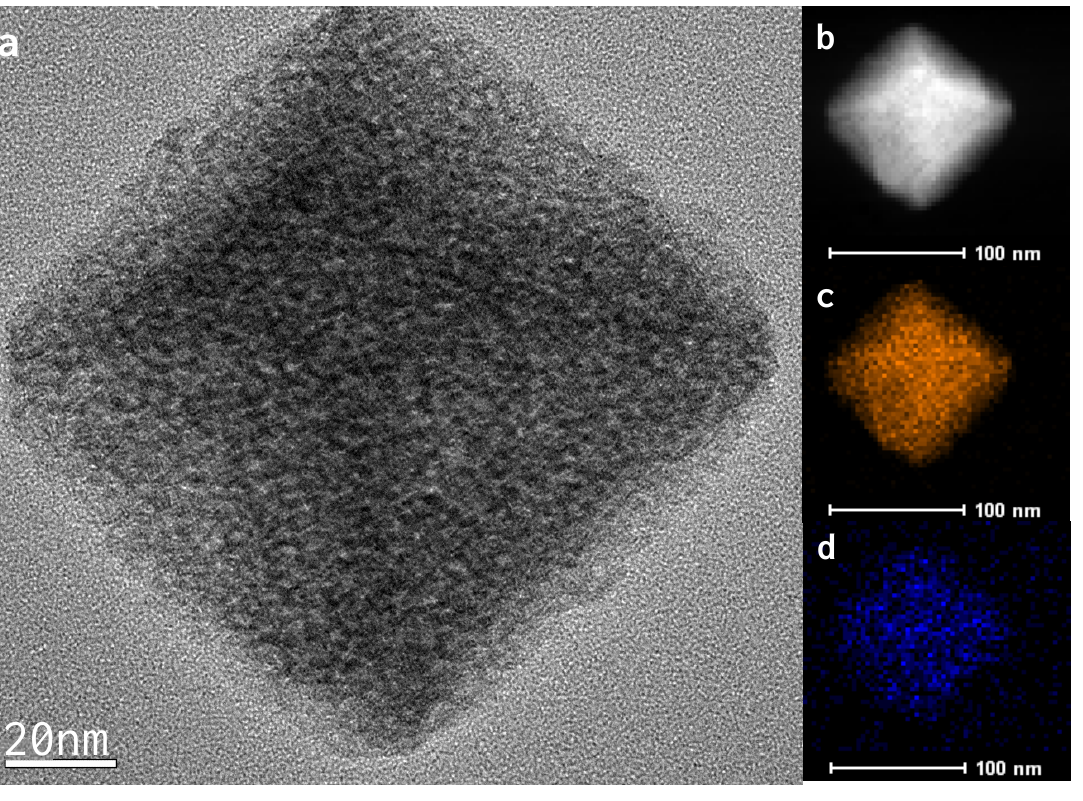
Figure 5. ( a ) TEM image of 0.5%CeO 2 / quasi-MIL-101 ( b ) High-angle annular dark-field scanning transmission electron microscopy image of 0.5%CeO 2 / quasi-MIL-101, and the corresponding elemental mapping images of ( c ) chromium, ( d ) cerium.